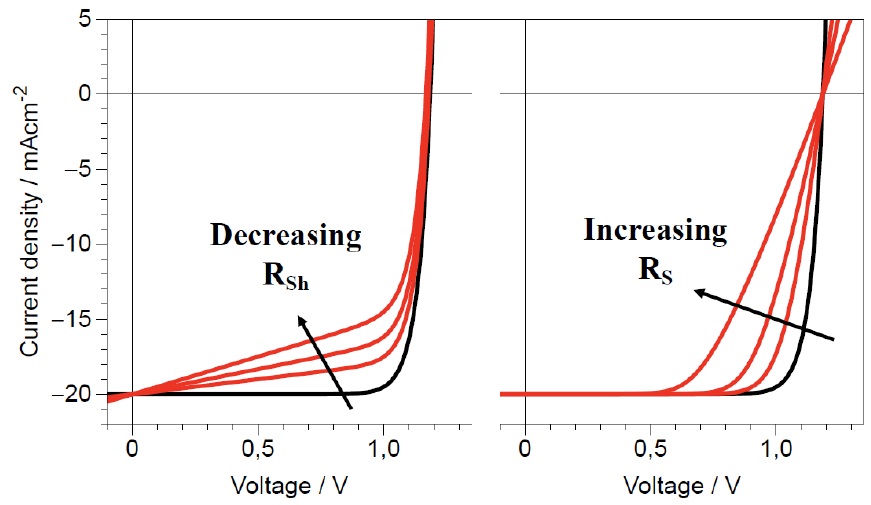
Fig. 5. – Effect of non-idealities on the current-voltage characteristics of a solar cell. On the left the effect of decreasing shunt resistance, which should ideally be equal to infinity; on the right the effect of increasing series resistance, which should ideally be equal to zero.